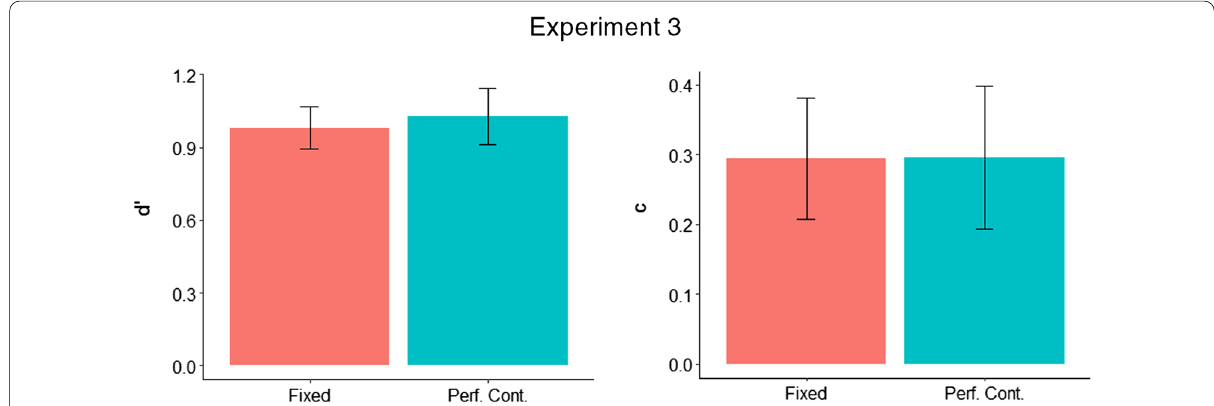
Fig. 8 d ′ and c for the fixed and performance‑contingent reward groups in Experiment 3 (error bars show 95%